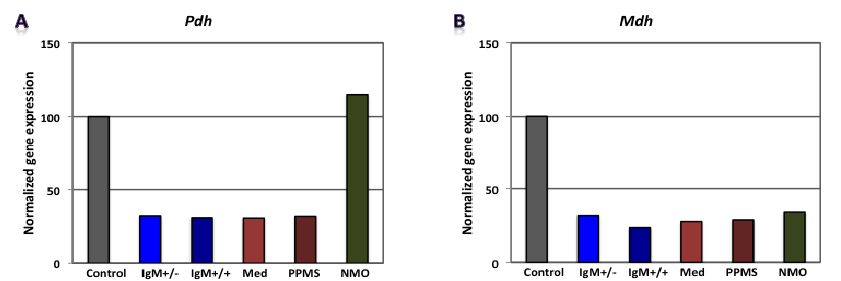
Figure 3. Normalized gene expression involved in tricarboxylic acid (TCA) cycle in CGNs treated with CSF of MS and NMO patients. ( A ) Pyruvate dehydrogenase, Pdh; ( B ) Malate dehydrogenase, Mdh. CGNs: cerebellar granule neurons; RMS (G+/M− and G+/M+): types of inflammatory MS; Spinal MS (Med); PP: Primary progressive multiple sclerosis; NMO: Neuromyelitis Optica.